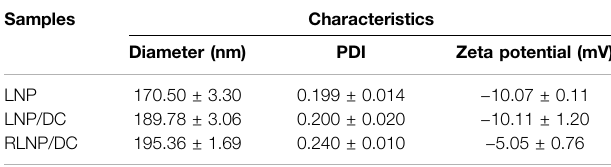
TABLE 1 | Properties of DHA and CQ-loaded LNPs.